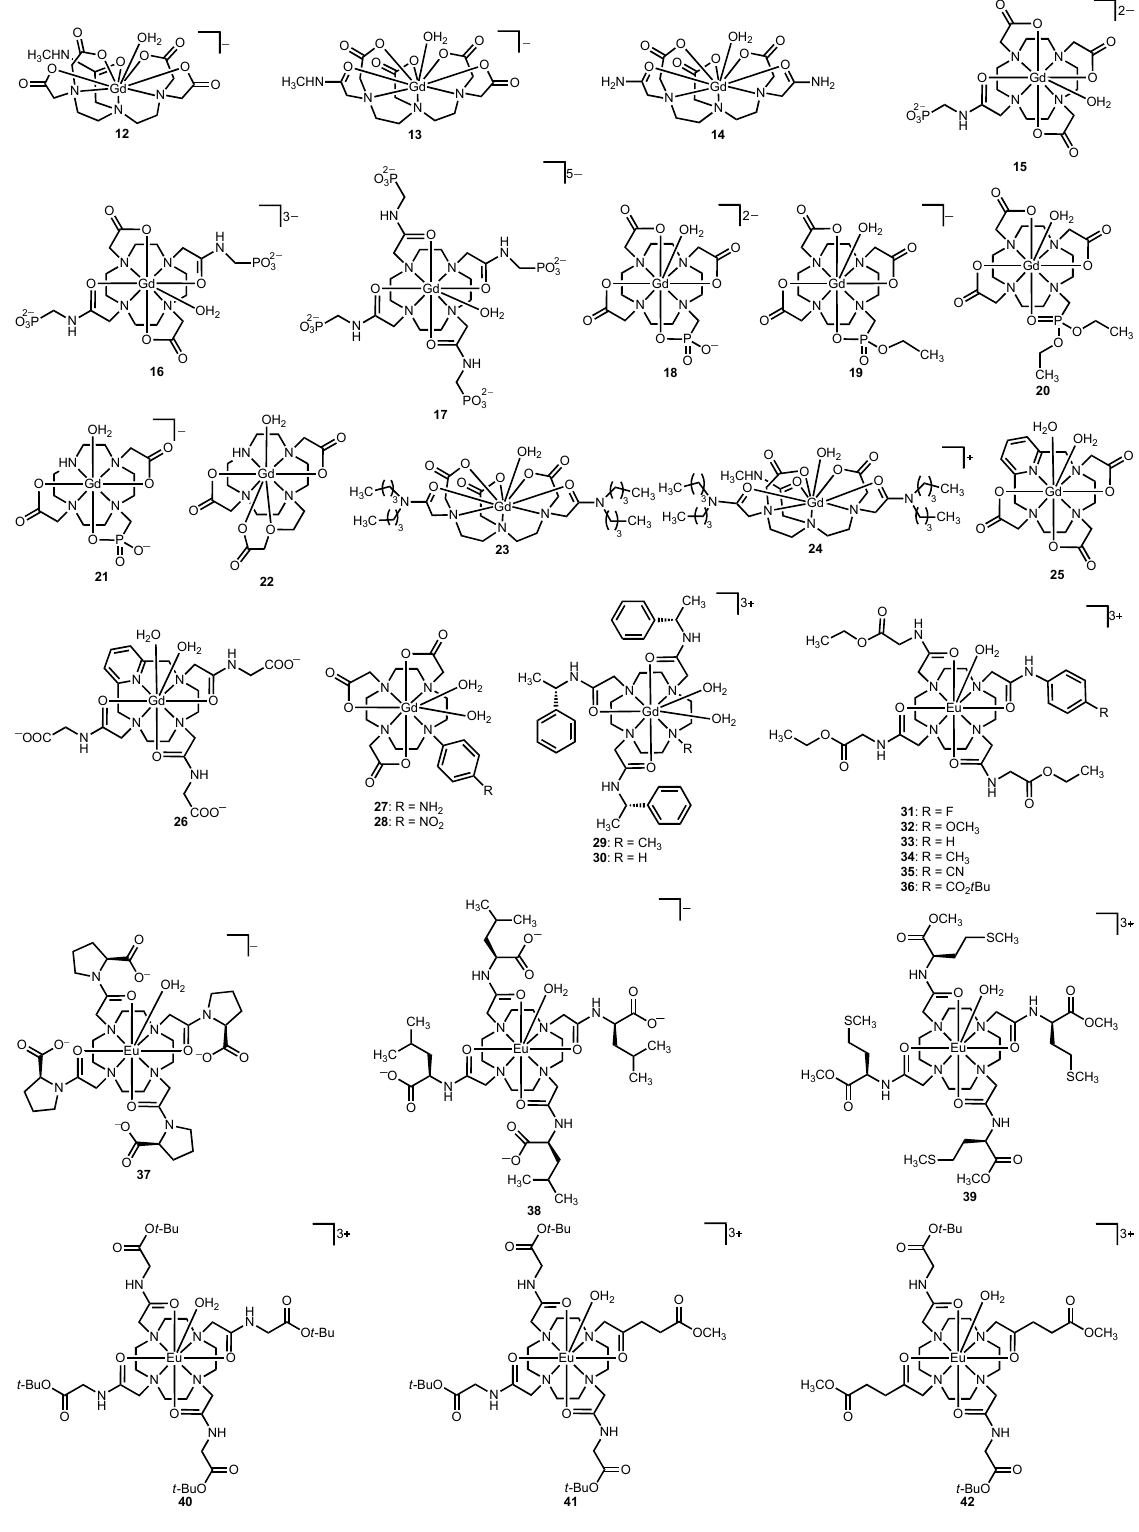
Figure 4. Representative Gd III - and Eu III -containing complexes that relate the influence of charge (compounds 12 – 26 ) and electron density of coordinating atoms (compounds 27 – 42 ) to water-exchange rate